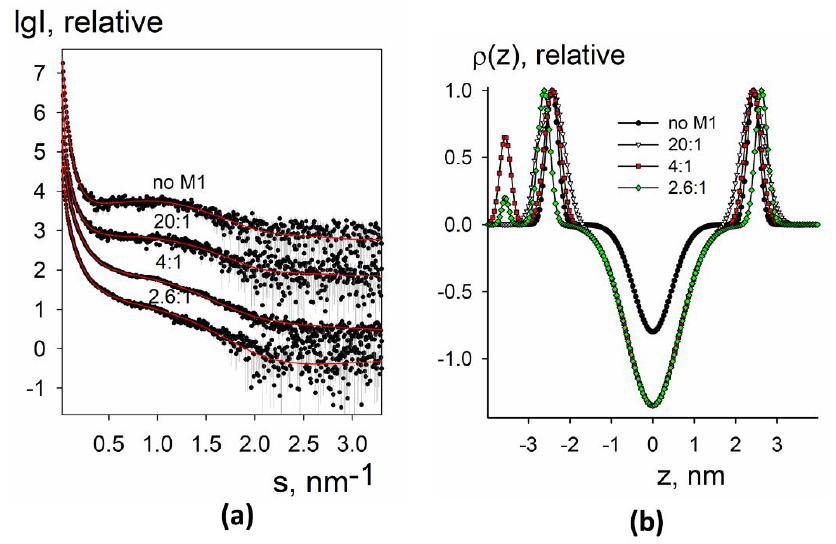
Figure 6. SAXS and BILMIX analysis of native liposomes composed of lipids extracted from A/Puerto Rico/8/34 (H1N1) virus envelope loaded with M1 protein. ( a ) Experimental are shown by dots with error bars, the fits obtained by BILMIX are shown as red curves. The curves are shifted by one logarithmic order for better clarity; ( b ) the restored electron density profiles of the lipid bilayer before (black curve) and after (color curves) loading with M1. The molar lipid:M1 ratios are the following: no M1, 20:1, 4:1, 2.6:1.